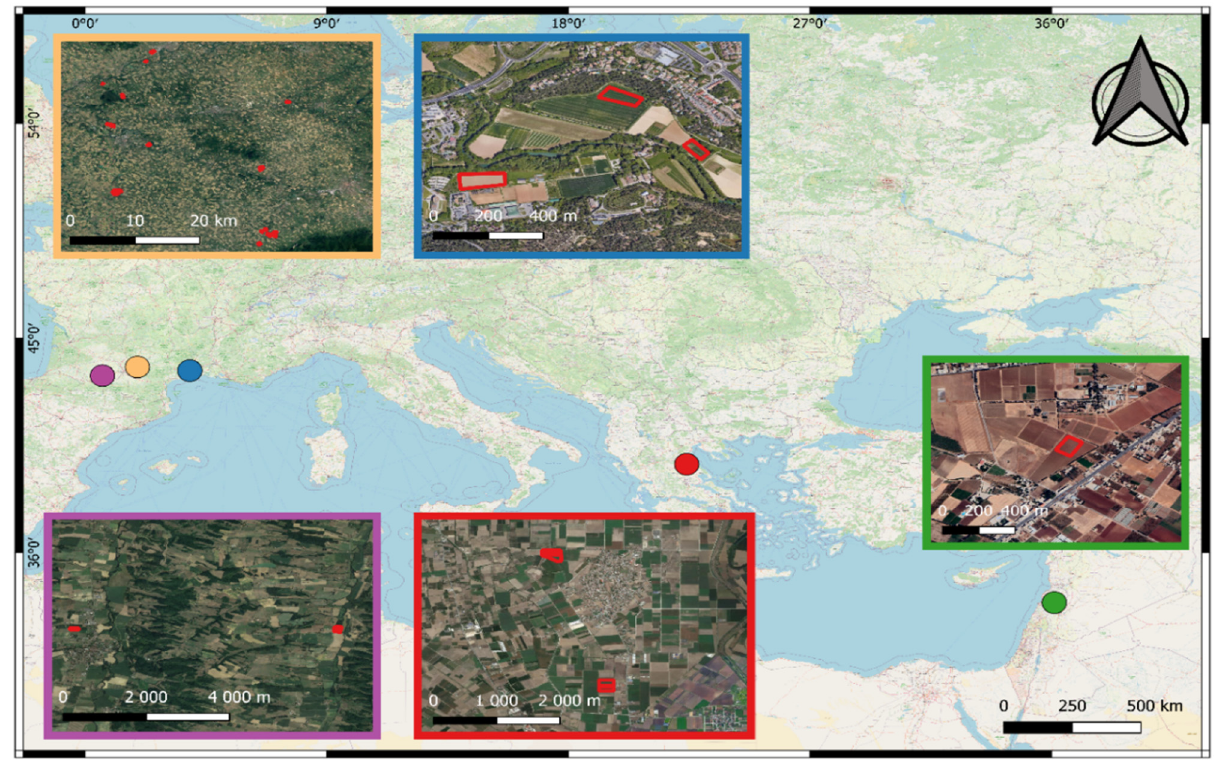
Figure 1. Location of study sites. Same-colored boxes and dots correspond to the same location. In green (LB), in red (GR), in blue (OE), in yellow (TR) and in magenta (OW). green (LB), in red (GR), in blue (OE), in yellow (TR) and in magenta